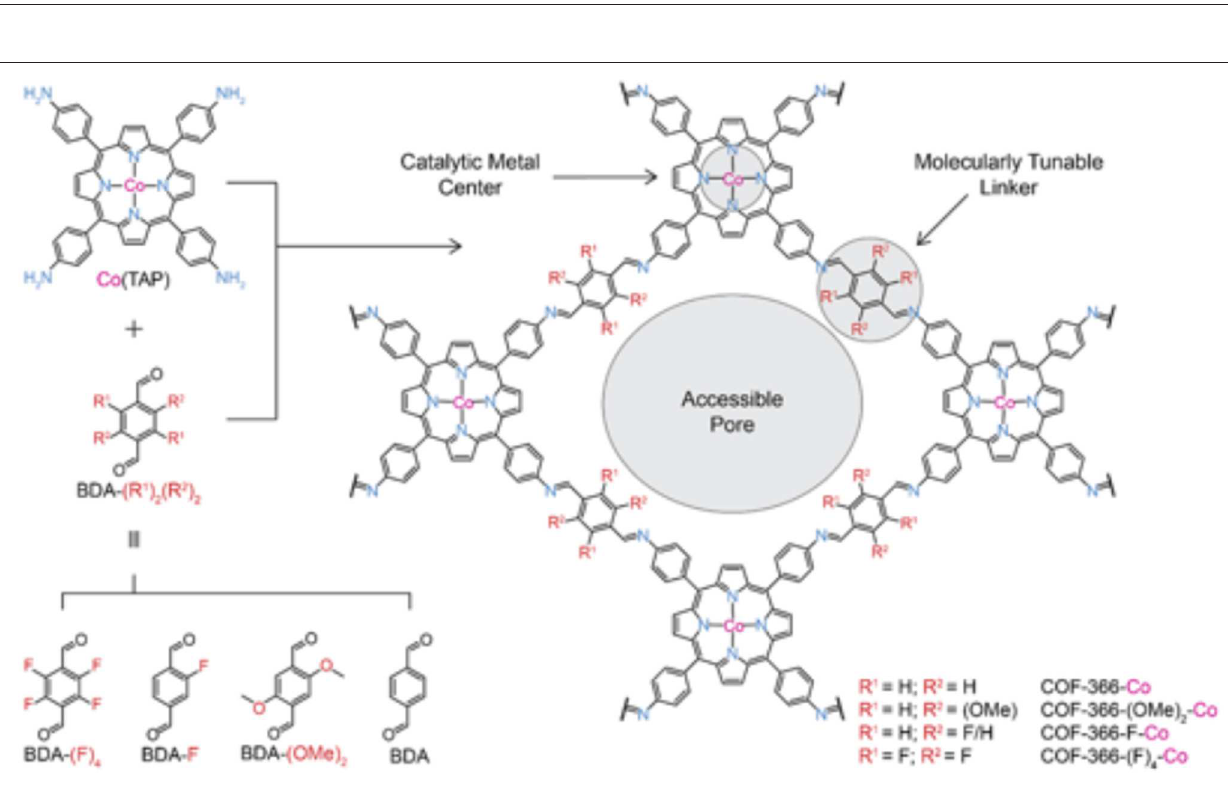
group to form ∗ CO. Yao et al. calculated the adsorption energy (E ad ) of CO on Co-Pc-PBBA to be − 0.36 eV, which is < -0.26 eV on